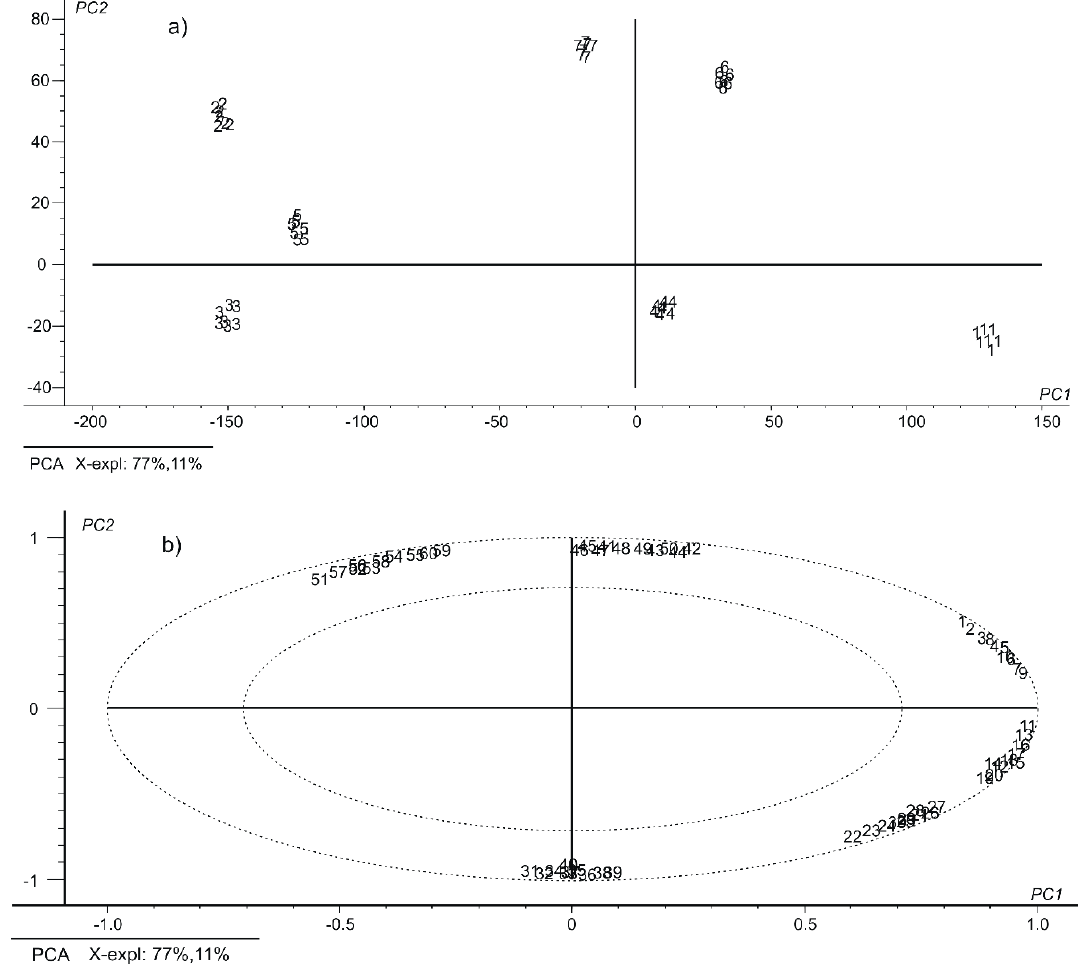
Figure 3. ( a ) Scores plot of the responses produced by the voltammetric sensor array when exposed to different water samples (wherein: 1) PD; 2) DS; 3) DL; 4) CP; 5) DP; 6) GR; 7) LN). ( b ) PCA loadings plot of the water samples from the voltammetric sensor array (wherein: 1–10 CoPc-SPE; 11–20 MB-SPE; 21–30 PB-SPE; 31–40 MWCNT/GNP-SPE; 41–50 MWCNF/GNP-SPE; 51–60 MWGPH/GNP-SPE).